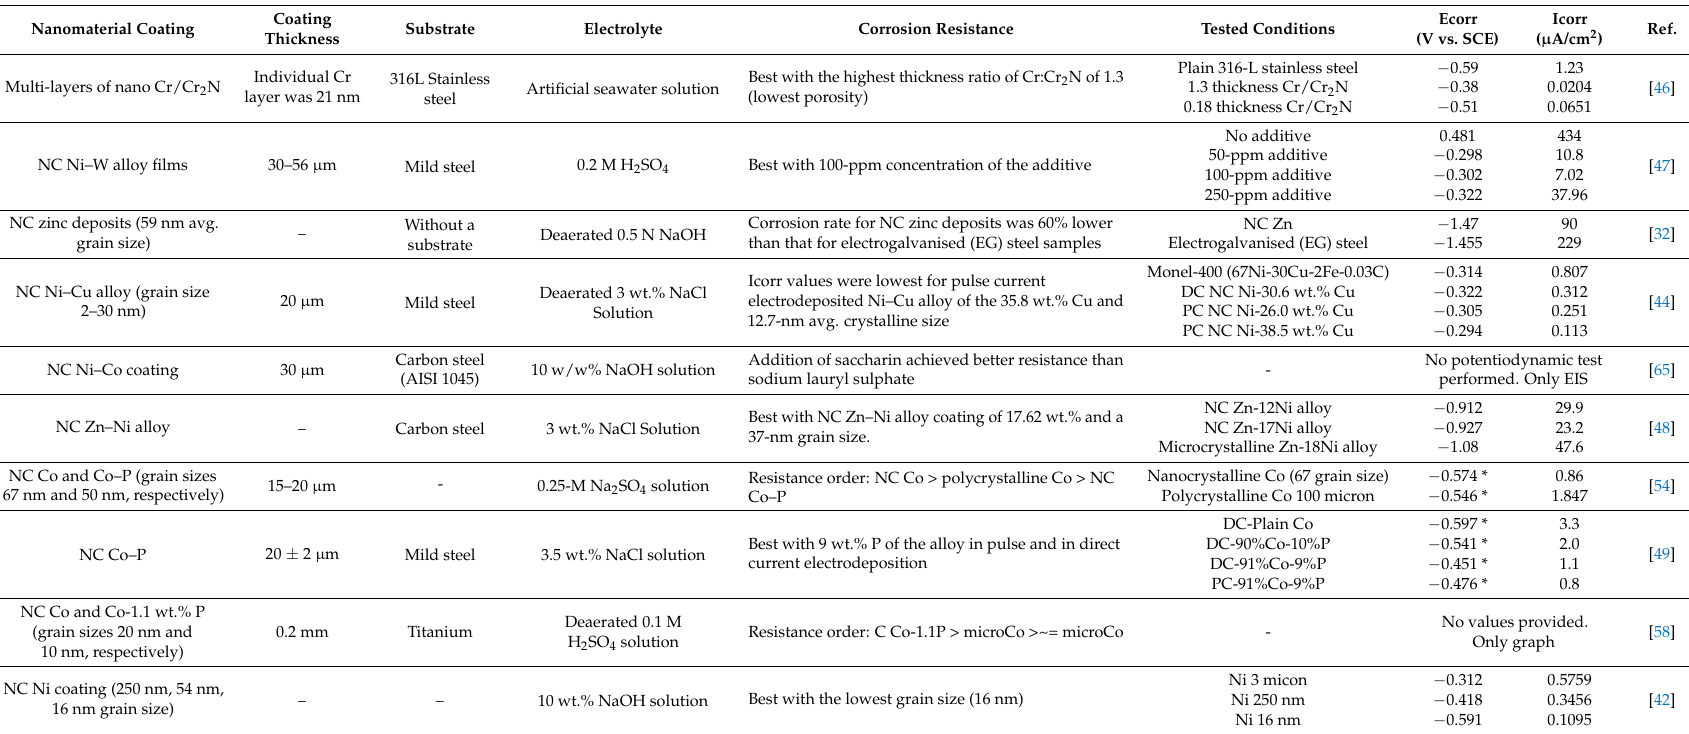
Table 1. Summary of some corrosion parameters of metallic